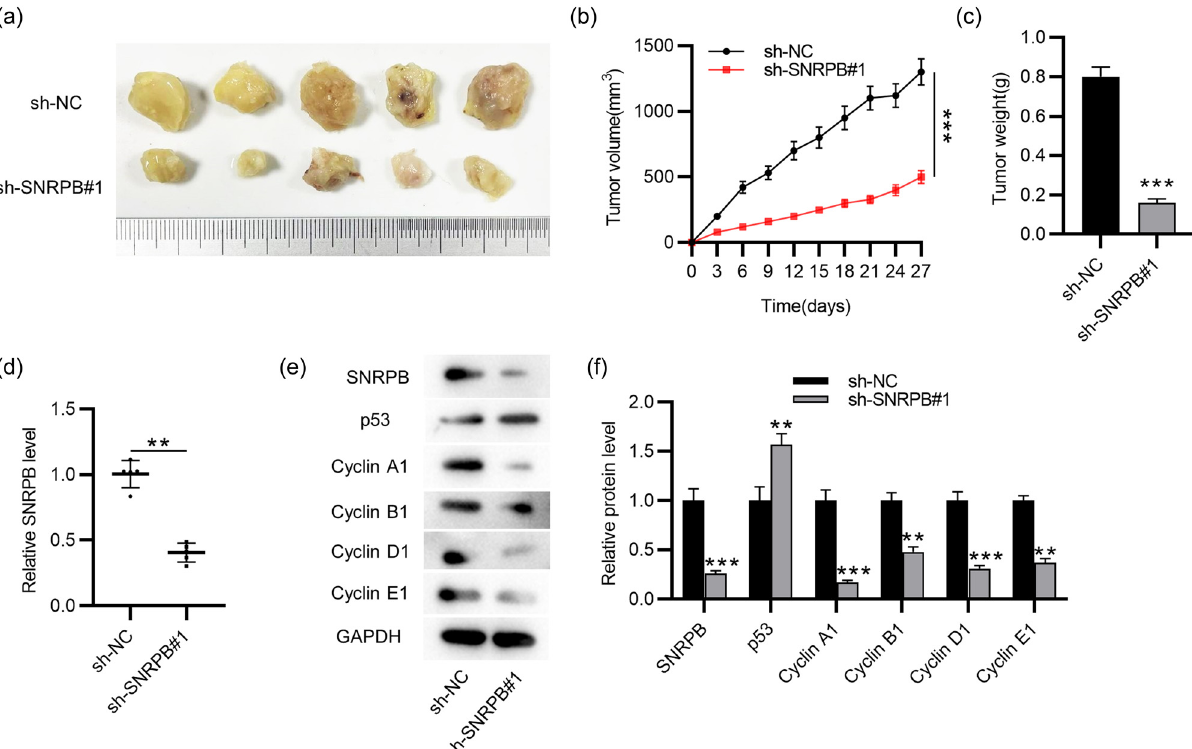
Figure 5: Knocking down SNRPB restrains tumor growth in vivo : ( a ) photographs of murine tumor samples, n = 5 per group, ( b ) tumor volumes of each group measured every 3 days, ( c ) measurement of tumor weight on the 27th day, ( d ) RT - qPCR analysis of SNRPB level in each group and ( e and f ) western blotting for evaluating levels of SNRPB, p53 and cell cycle - related proteins in murine tumors. Student ’ s t - test was performed for statistical analysis. ** p < 0.01, *** p <